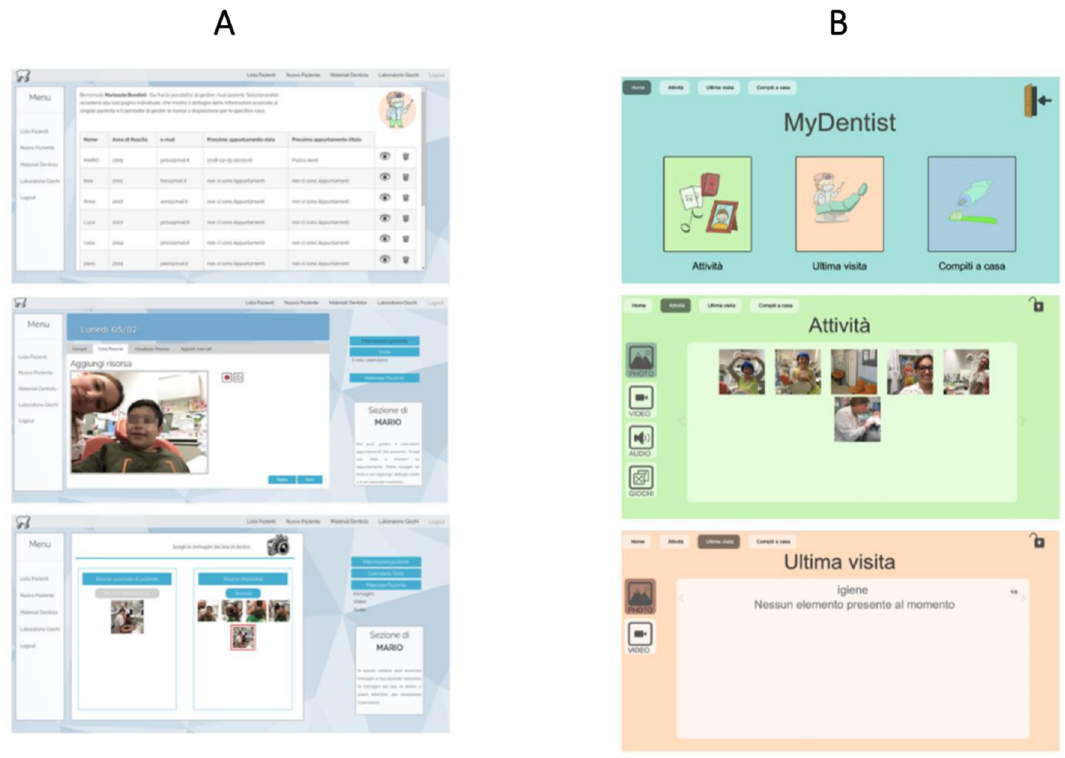
Figure 1. The MyDentist User Interfaces: the dentist’s section ( A ) and the patient’s section ( B ).